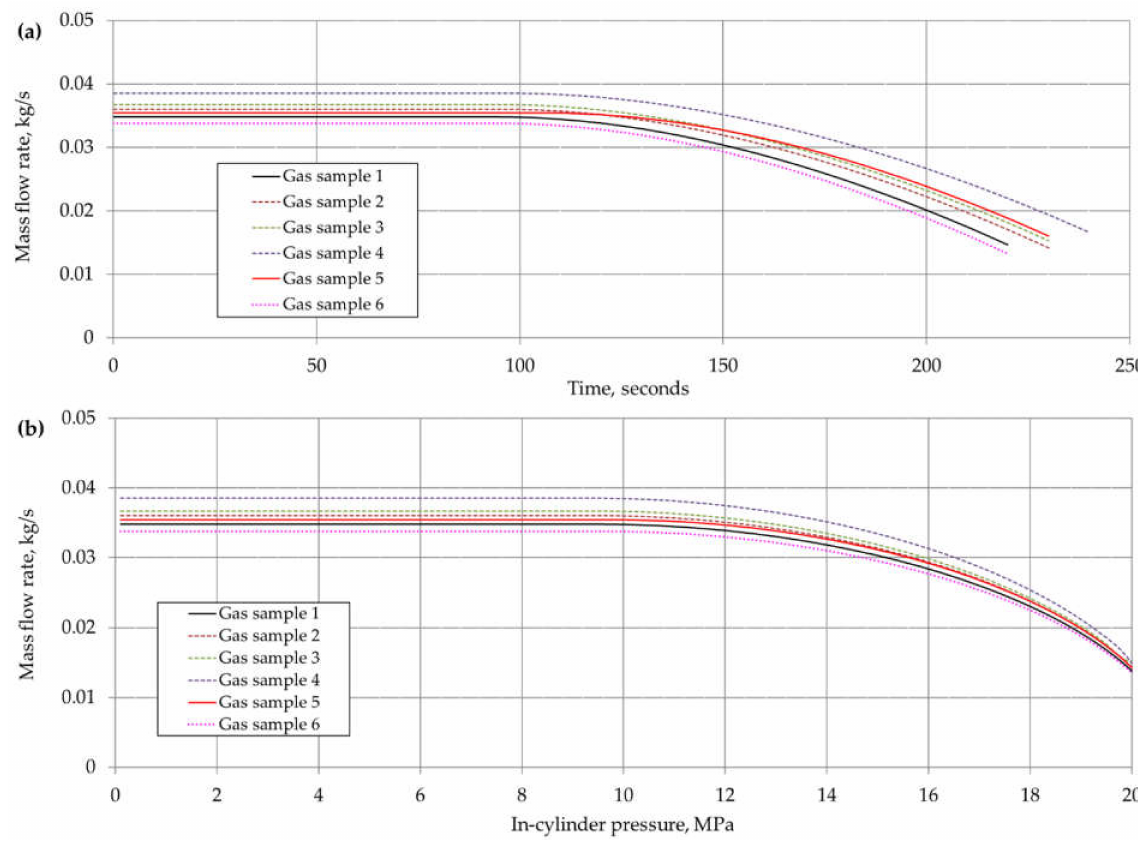
Figure 6. Mass flow rate change of the considered natural gas mixtures during the composite tank fast filling process: ( a ) vs. pressure change in the composite tank; ( b ) vs. filling time of the composite